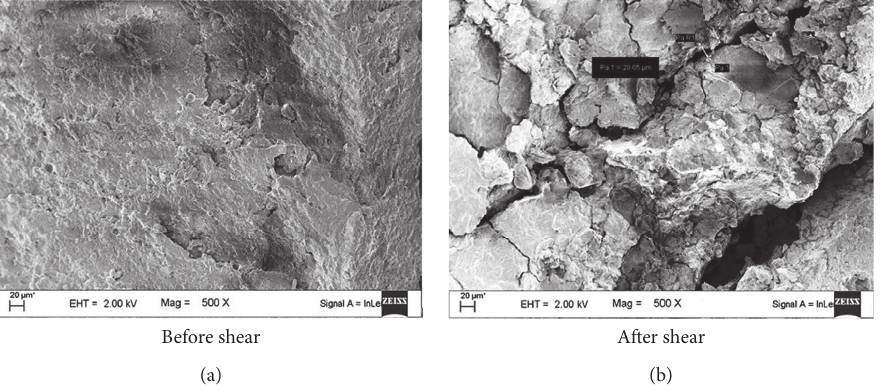
Figure 5: Surface before and after shearing of rubber fragments (modified from [138]). (a) Before shear and (b) after